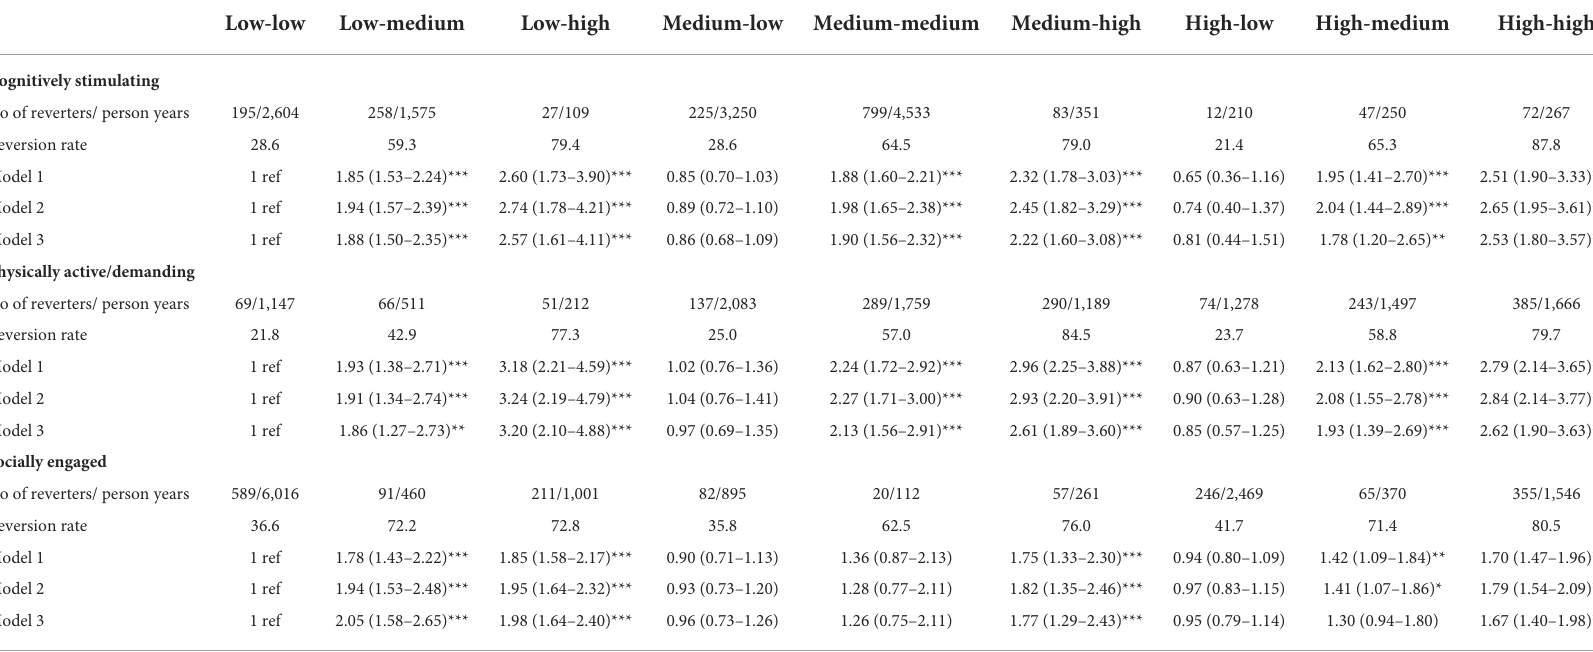
TABLE 2 The association between cognitively stimulating, physically active/demanding, and socially engaged LAE change patterns and MCI